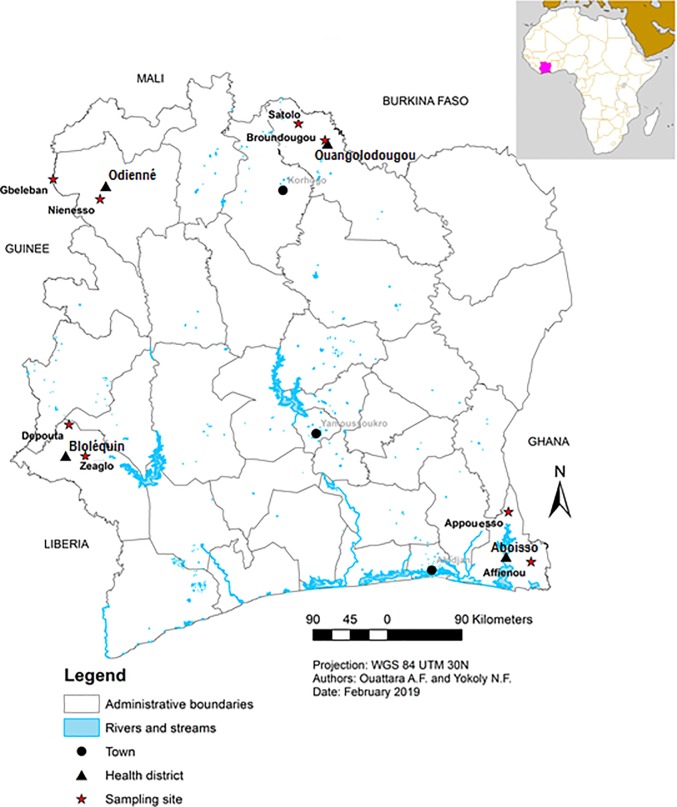
Location of the study sites in cross-border health districts of Côte d’Ivoire.This map was created using Arcmap version 10.